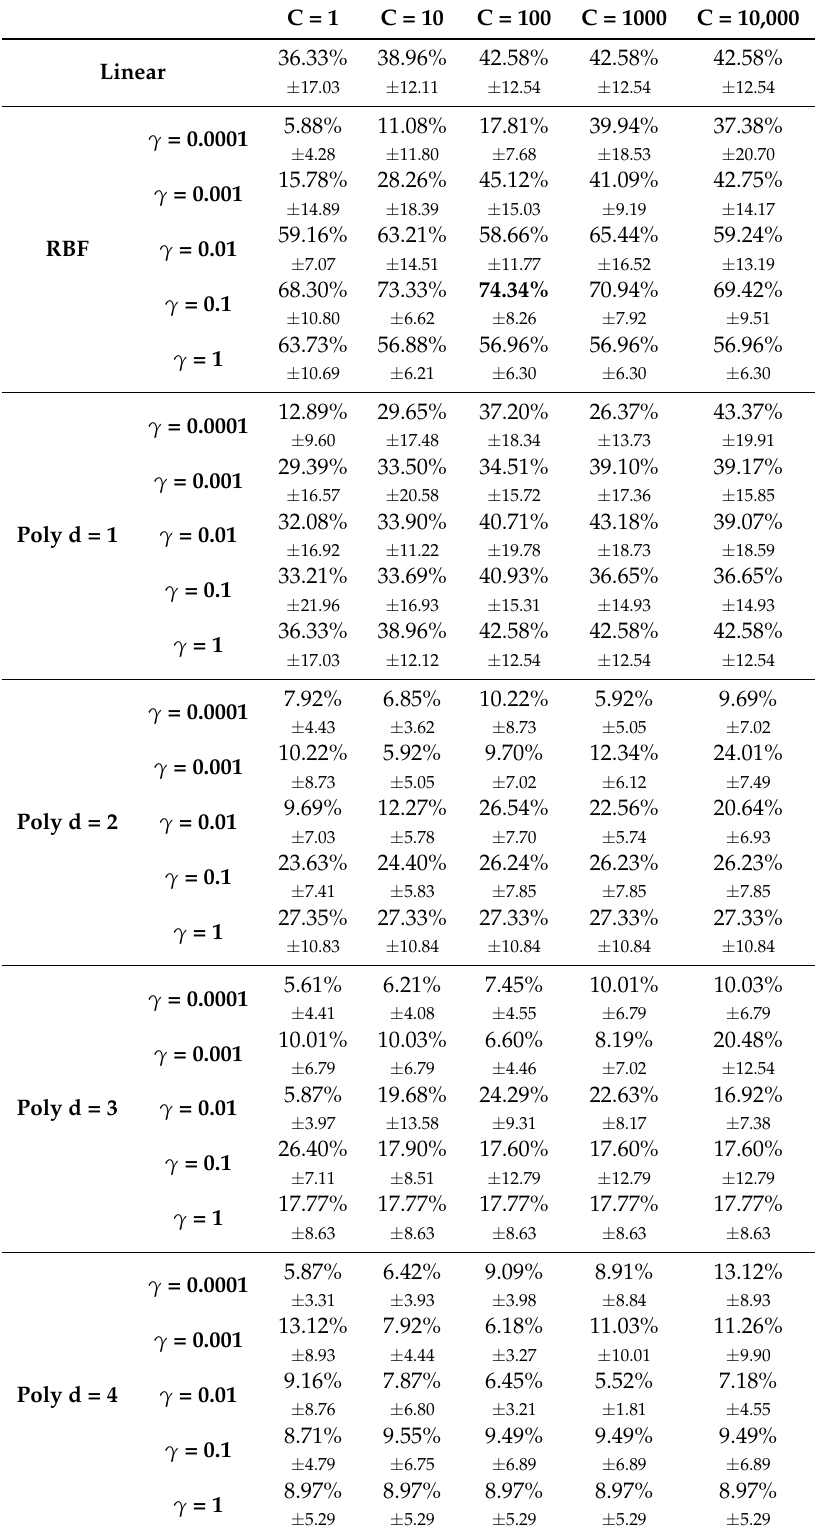
Table 8. Mean f1-scores achieved for each combination of kernel, C, γ and degree hyperparameters in the grid search. The best result found is highlighted in